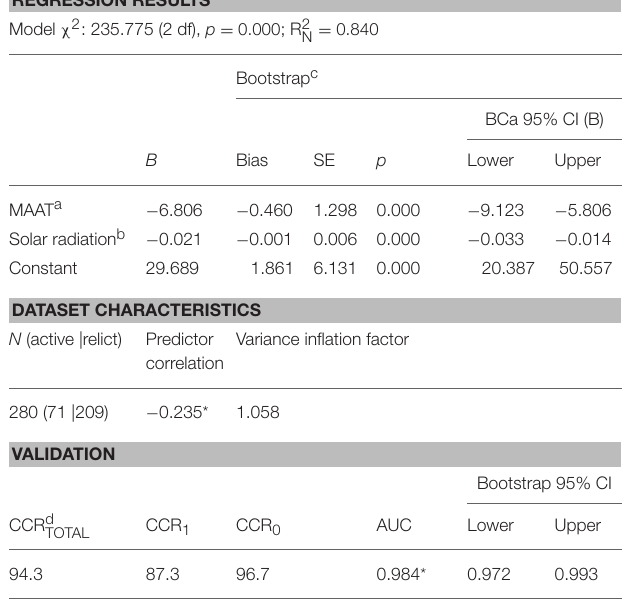
TABLE 1 | Logistic regression output, dataset characteristics, and validation statistics. REGRESSION